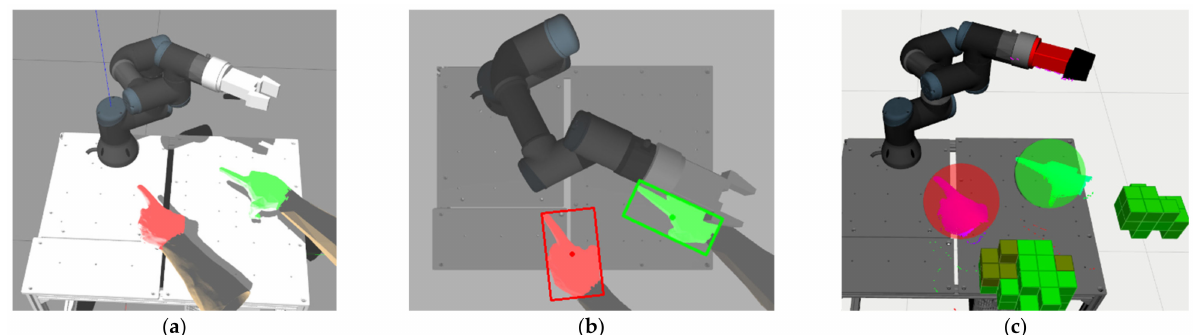
Figure 9. Snapshot of HMI tracking process: ( a ) Gazebo simulation; ( b ) upper camera image; ( c ) visualisation of the recognised HMI positions and segmented point cloud in RViz (HMIs are represented by